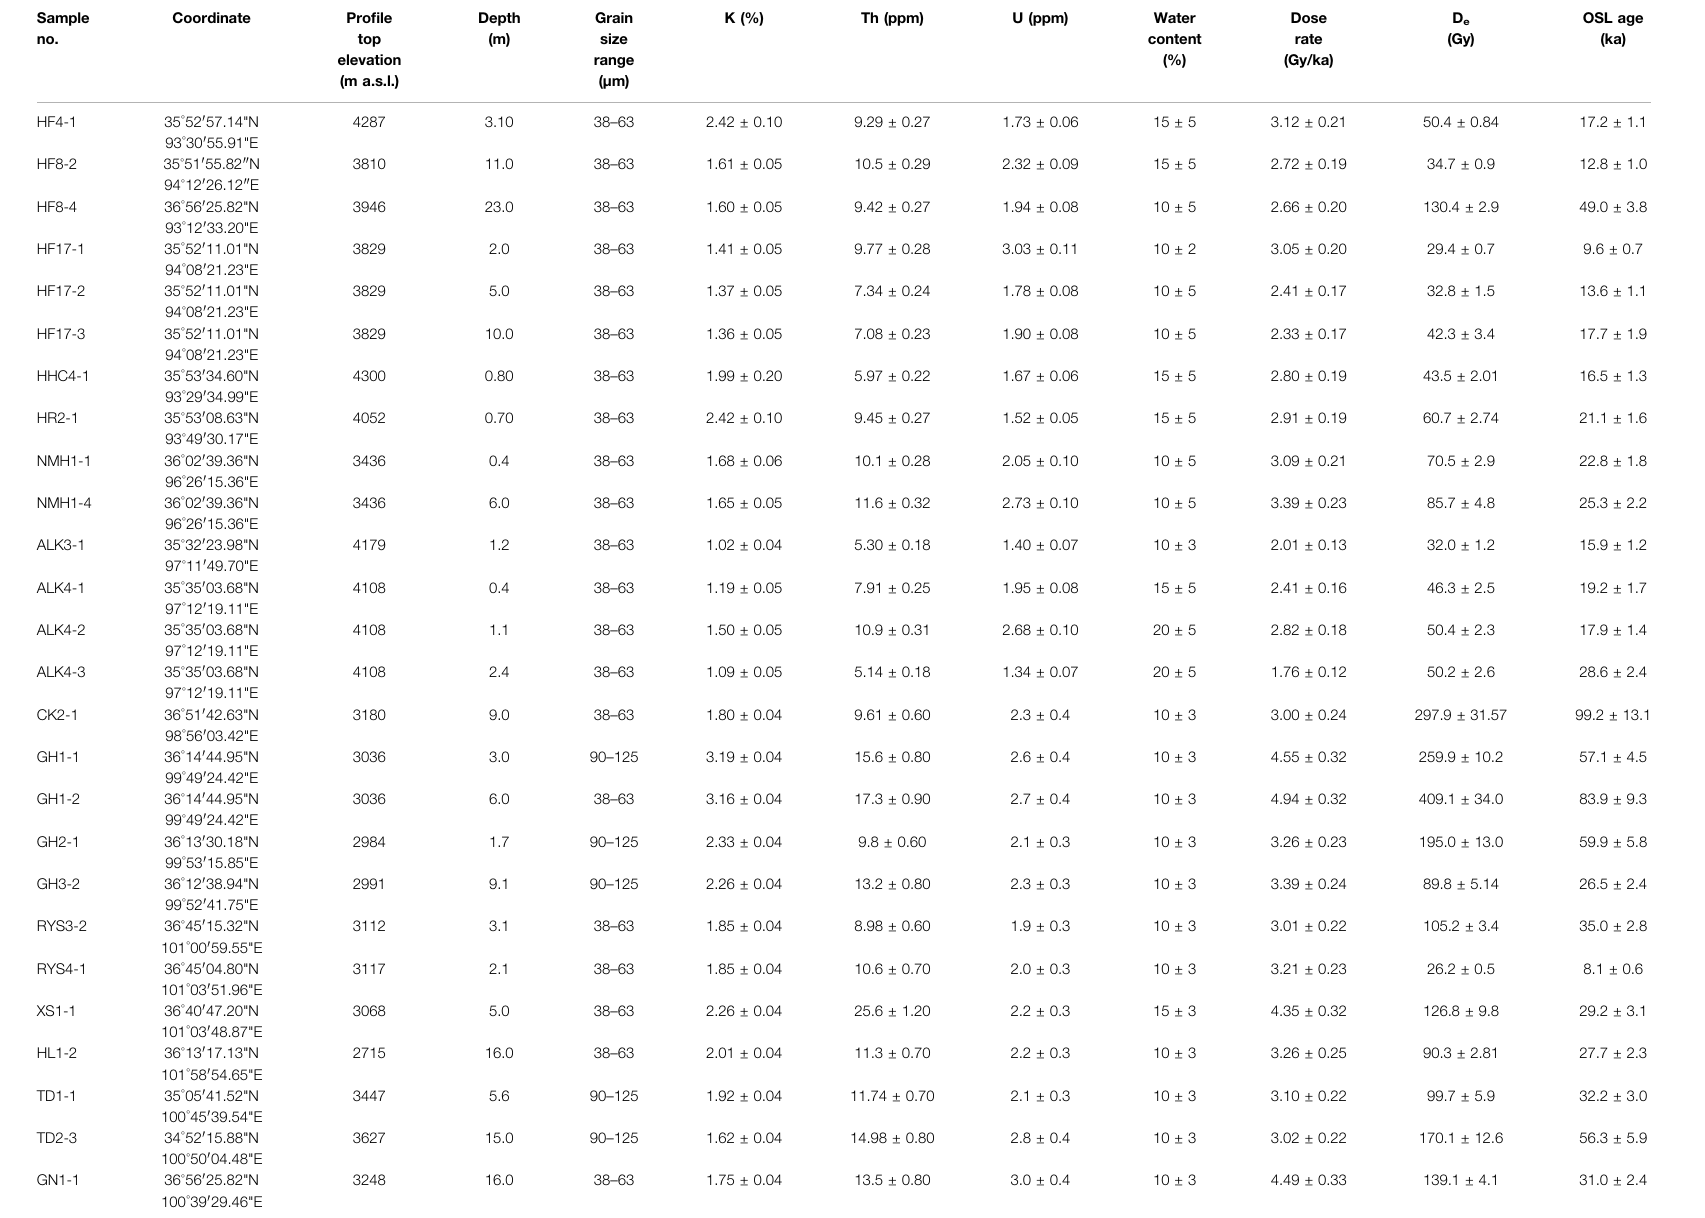
TABLE 1 | OSL sample information and dating results of the alluvial sections. Sample